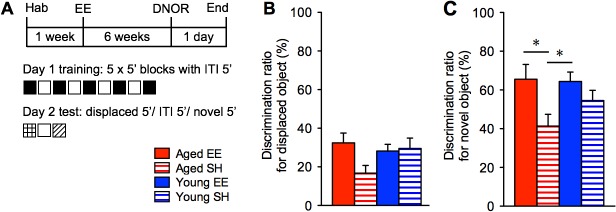
Recognition memory in aged and young mice following respective housing conditions.(A) Experimental design of the displaced and novel object recognition memory (DNOR) tasks over two days in 5 min blocks with 5 min ITI (n = 9, 8, 9, 8 for Aged EE (solid red), Aged SH (red stripes), Young EE (solid blue), Young SH (blue stripes), respectively). Recognition test of a displaced object 24 hours after training (B), shown as a ratio of time spent with the displaced object over all objects, show no difference in group preferences for the displaced object (F
3,30 = 2.216). Test for recognition of a novel object shows differing group preferences for the novel object relative to the pre-existing objects (C), shown as a discrimination ratio for the novel object (F
3,30 = 3.316). *p < 0.05, **p < 0.01, ***p < 0.001. Shown as mean ± s.e.m.